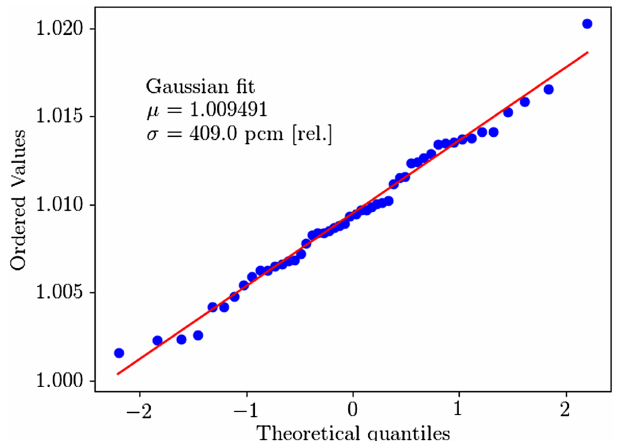
Fig. 2. Probability plot to deduce the uncertainty related to the k eff for the contribution of 238 U (n,f)